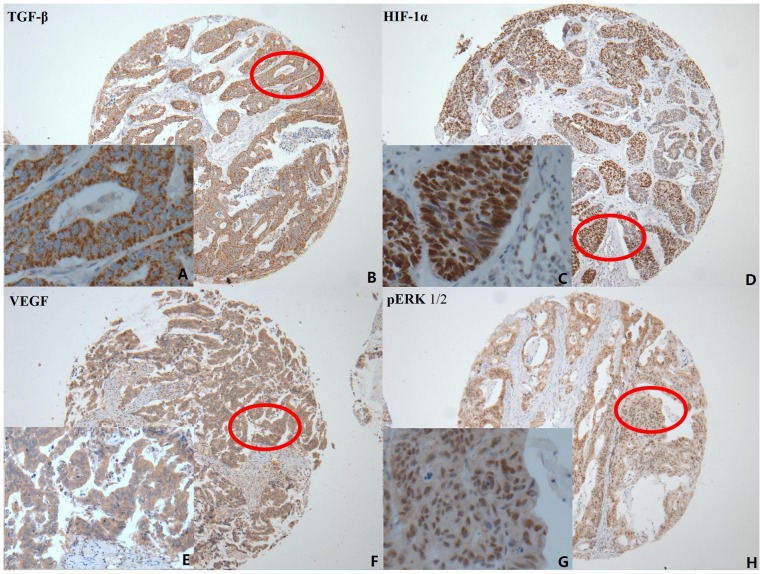
Immunohistochemical staining of TGF-β, HIF-1α, VEGF and pERK 1/2 expression in gastric cancer.A. Immunohistochemical staining of TGF-β was located mainly in the cytoplasm of tumor cells (positive expression ×400); B. TGF-β original magnification ×100; C. HIF-1α was located mainly in the nucleus of tumor cells (positive expression ×400); D. HIF-1α original magnification ×100; E. VEGF was located mainly in the cytoplasm of tumor cells (positive expression ×400); F. VEGF original magnification×100; G. pERK1/2 was located in the cytoplasm and nucleus of tumor cells (positive expression ×400); H. pERK1/2 original magnification ×100.